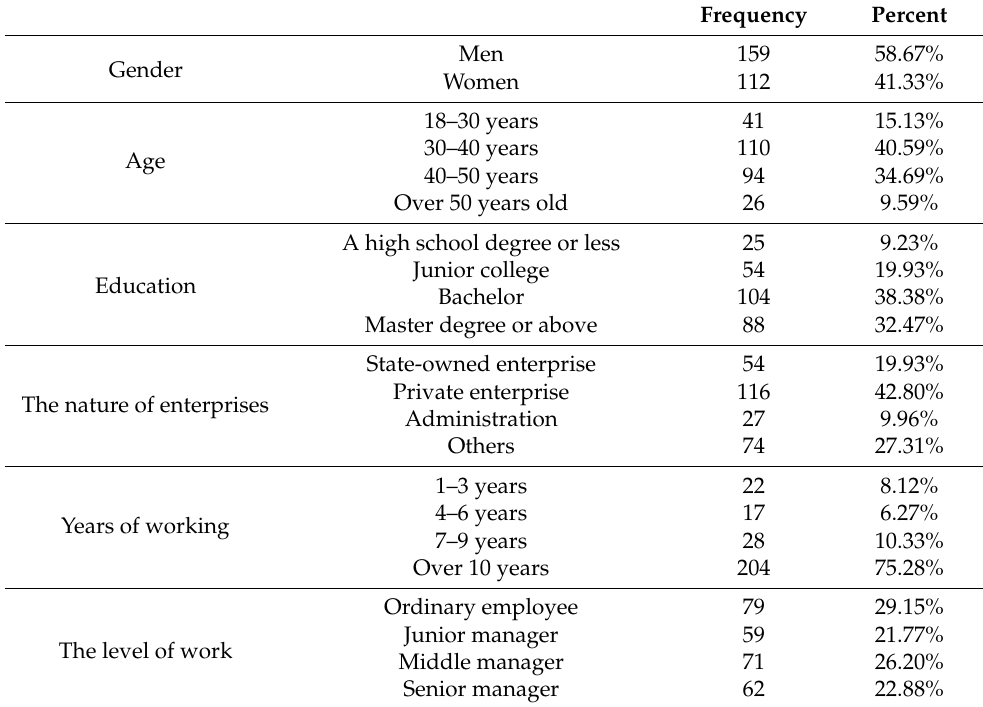
Table 1. Sample analysis ( N =